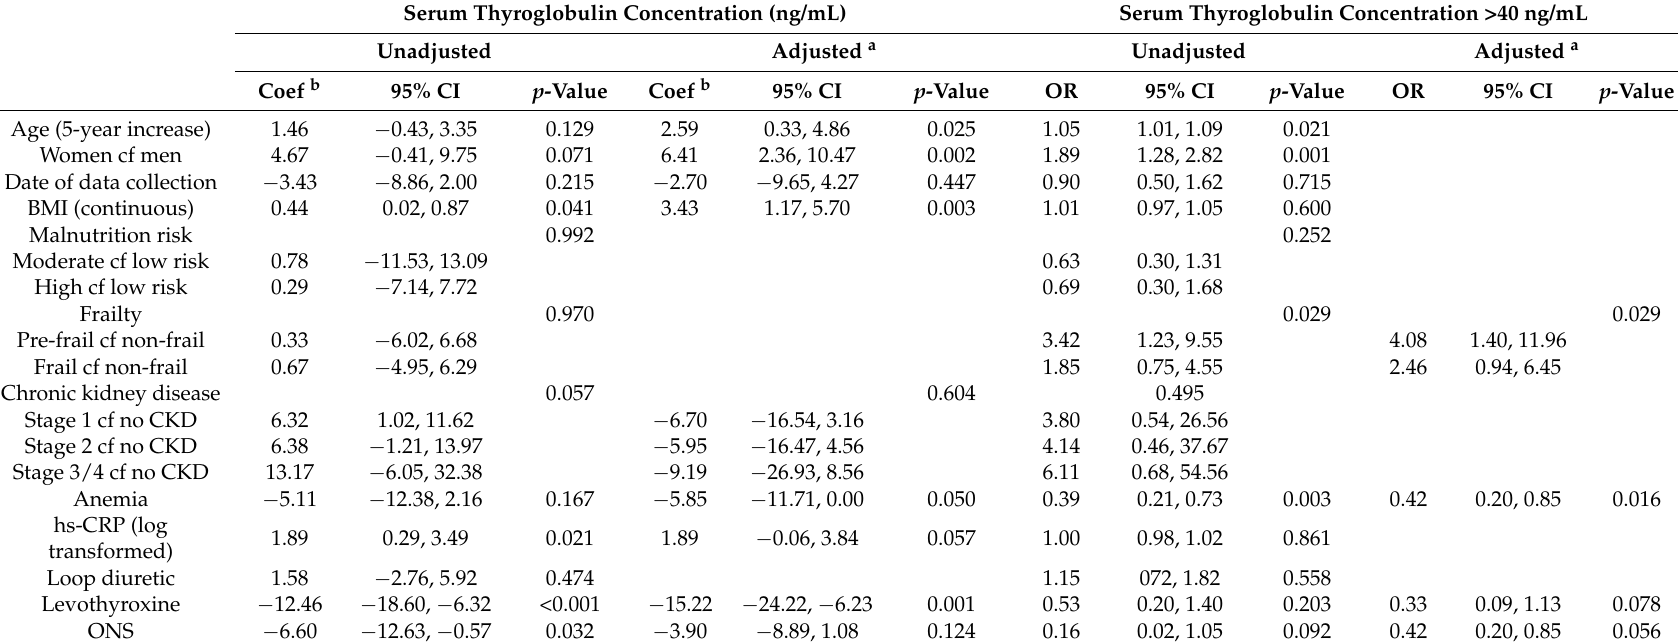
Table 4. Predictors of serum thyroglobulin concentrations of New Zealand rest home residents